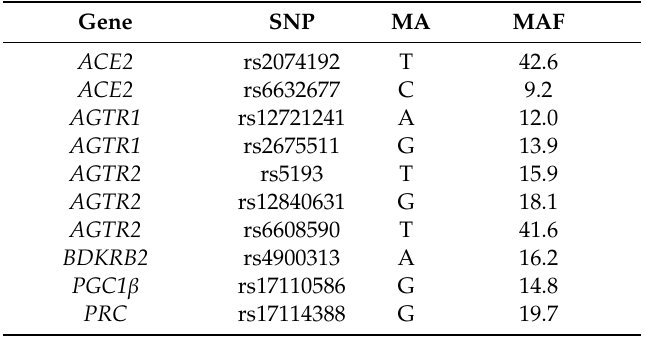
Table A2. List of SNPs discarded for analyses because did not meet the Hardy–Weinberg equilibrium.